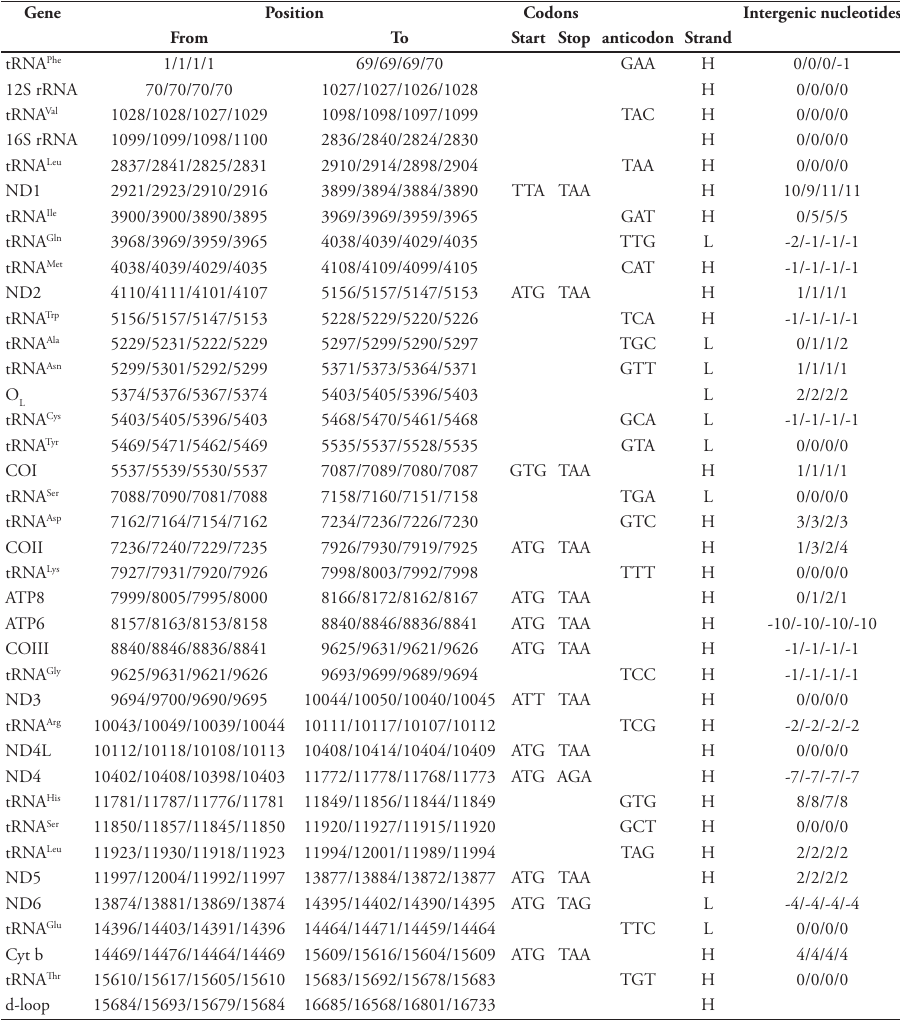
Table 4. Characteristics of the four newly determined Trichiurus mitogenomes.